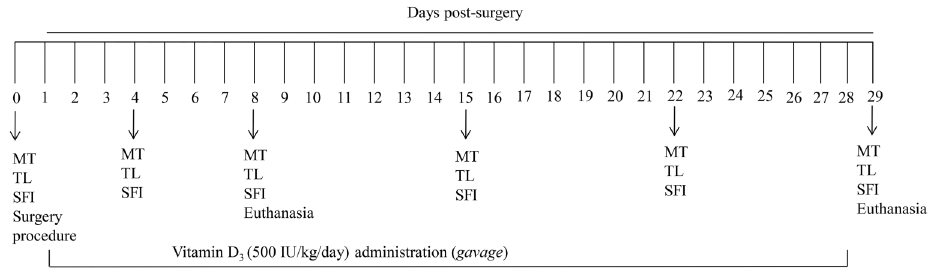
Figure 1. Timeline with days of treatments, behavior tests, and euthanasia of rats. MT: mechanical withdrawal threshold; TL: thermal withdrawal latency; SFI: sciatic functional index.